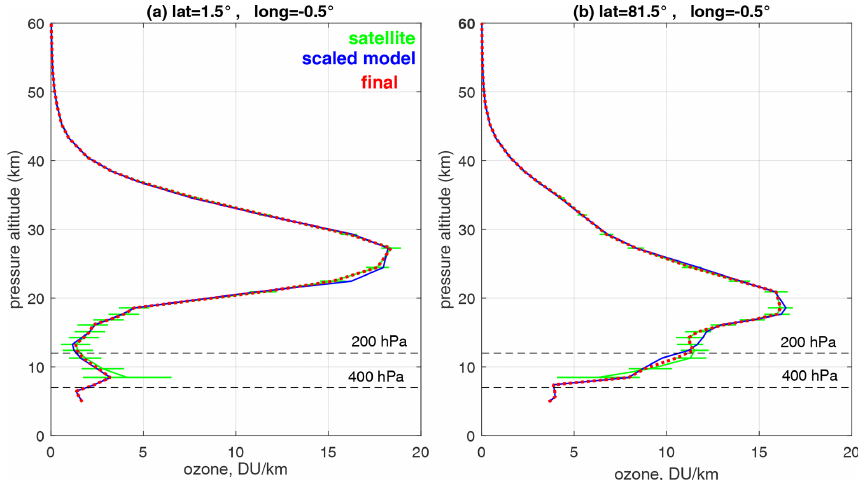
Figure 9. Illustration of transition to model-adjusted profiles at lower altitudes for tropical (a) and polar (b) regions. The vertical coordinate is pressure altitude z = 16log 10 (P 0 /P) , where P 0 = 1013hPa is the standard pressure, and P is pressure (in